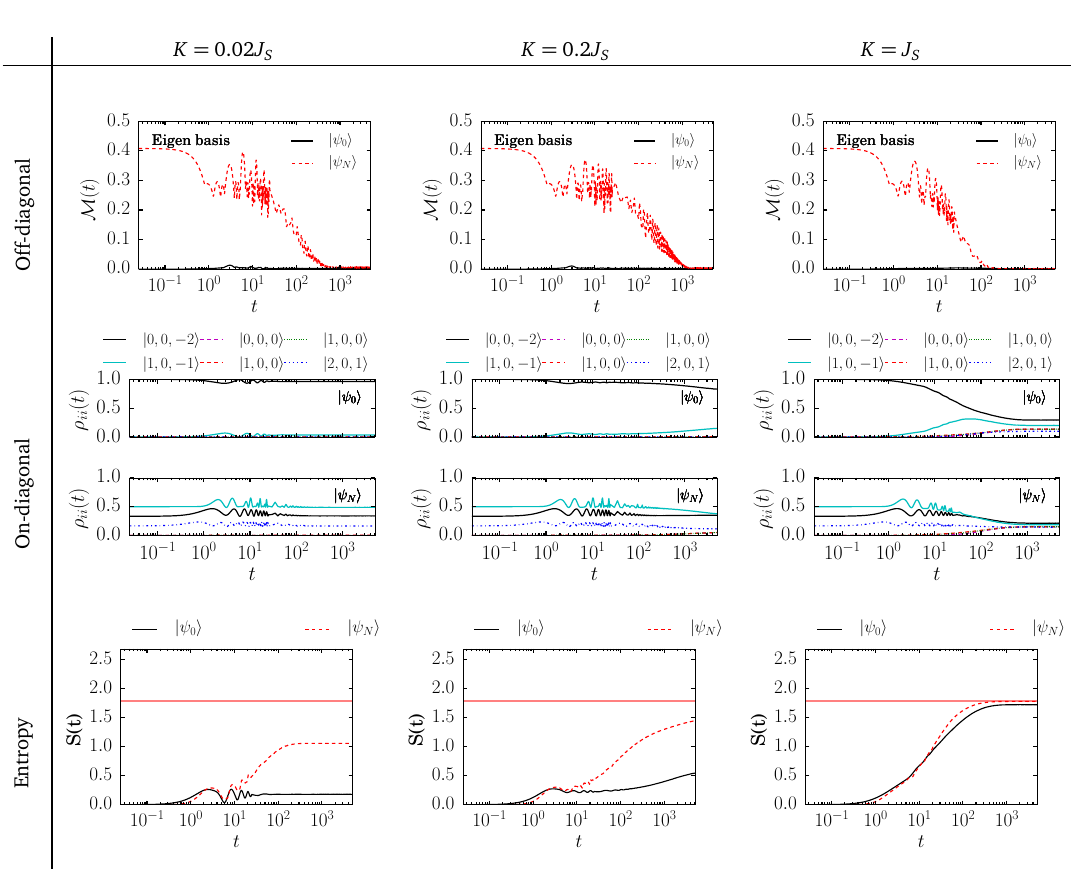
( t ) in the energy eigenbasis whereby Figure 5: Time-evolution of the reduced density matrix ρ ij = 4 particles) is weakly connected ( I = 0.25 J the central-system ( N ) to an environment of S S N (cid:69) = 16 particles via random antiferromagnetic Ising coupling. Each column correspond to different intra-environment strengths K . The initial states of the central-system (CS) – namely, 〉 and the Néel-state | ψ 〉 = |↑↓↑↓〉 – are indicated in the panels. The the ground state | ψ N 0 maximum off-diagonal component (cid:77) ( t ) [ Eq. (18) ] is depicted in the top row. The middle row shows the diagonal components of ρ ( t ) whereby the states in the legend correspond to quantum numbers | S , S z , E 〉 where E and S denote the energy eigenvalue and the tot tot tot total spin (of the CS), respectively. The von Neumann entropy S ( t ) is shown in the bottom = 0 row whereby the red horizontal line indicates the maximum value attainable in the S z tot / ħ h ≡ t subspace. Time t has been made dimensionless in units of J and ħ h , i.e. t (cid:48) → t (cid:48) J S S